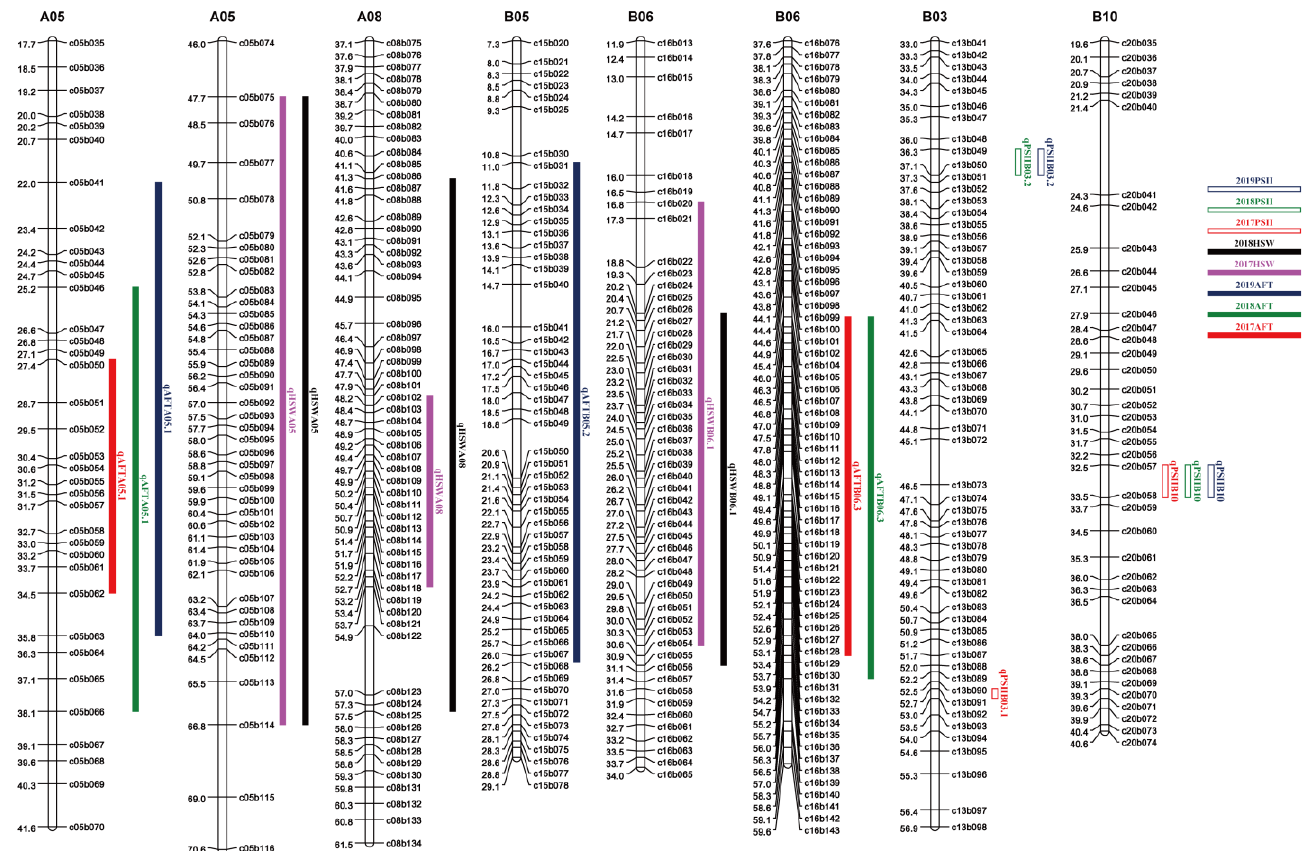
Figure 3. Distribution of QTLs for traits of resistance to aflatoxin contamination and HSW on the genetic map. Table 5. Comparison of unconditional and conditional QTLs for ATC and HSW in the RIL